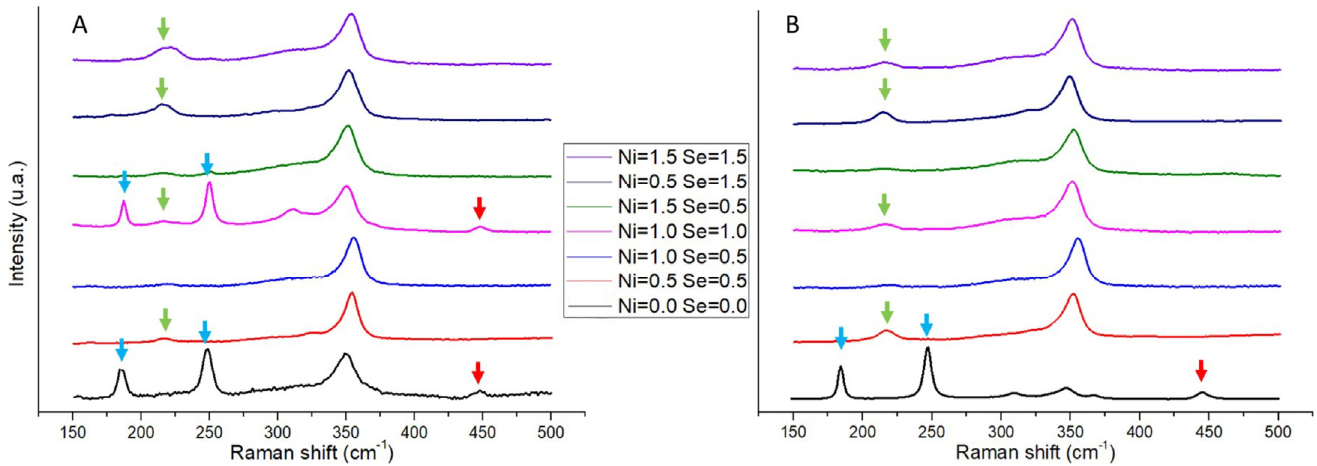
Figure 5. Raman spectra of Cu 12 − x Ni x Sb 4 S 13 − y Se y samples after casting ( A ) and after annealing ( B ). The peaks pertaining to the tetrahedrite phase are located in the 315 and 348 cm − 1 shifts. Arrows indicate the peaks not related to the tetrahedrite phase: green arrows — the Cu ‐ S chemical bond of ejected material; blue arrows — the Sb ‐ S chemical bond of ejected material; and red arrows — the Anilite (Cu 7 S 4 ) secondary phase.